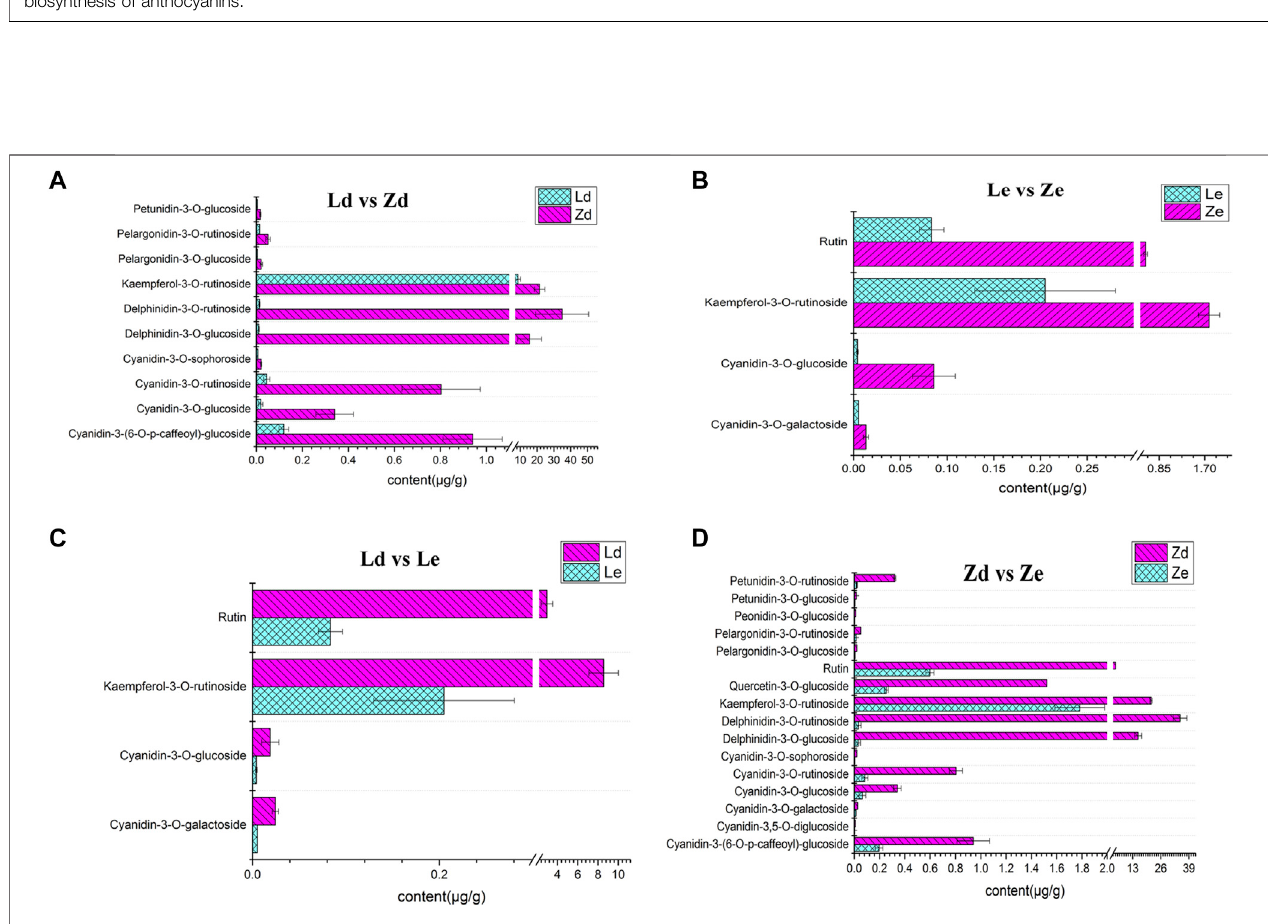
FIGURE7| Contentofvarious fl avonoids andanthocyaninsineggplant peelsamplesfrom thefruitapex(Ld andZd)and under thecalyx (Leand Ze) ofLand Zline eggplants,respectively. (A) Contentofdifferent metabolites infruitpeelfrom theapexofL(Ld) and Z(Zd)eggplants. (B) Content ofdifferentmetabolites infruitpeelfrom underthecalyxofL(Le)andZ(Ze)eggplants. (C) Contentofdifferentmetabolitesinvolvedinfruitpeelcolorbetweentheapex(Ld)andunderthecalyx(Le)offruitsfromL. (D) Comparison of the content of different metabolites involved in fruit peel color between the apex (Zd) and under the calyx (Ze) of fruits from Z.